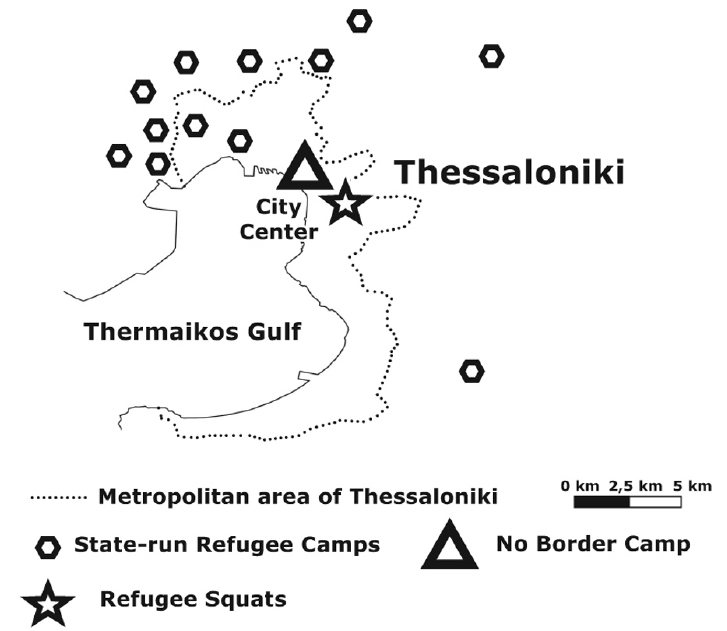
Figure 1. Location of State-run camps, refugee squats and No Border camp. Source: author. It is especially important that the refugees in the housing project of Orfanotrofio met political groups and local residents and created a new political